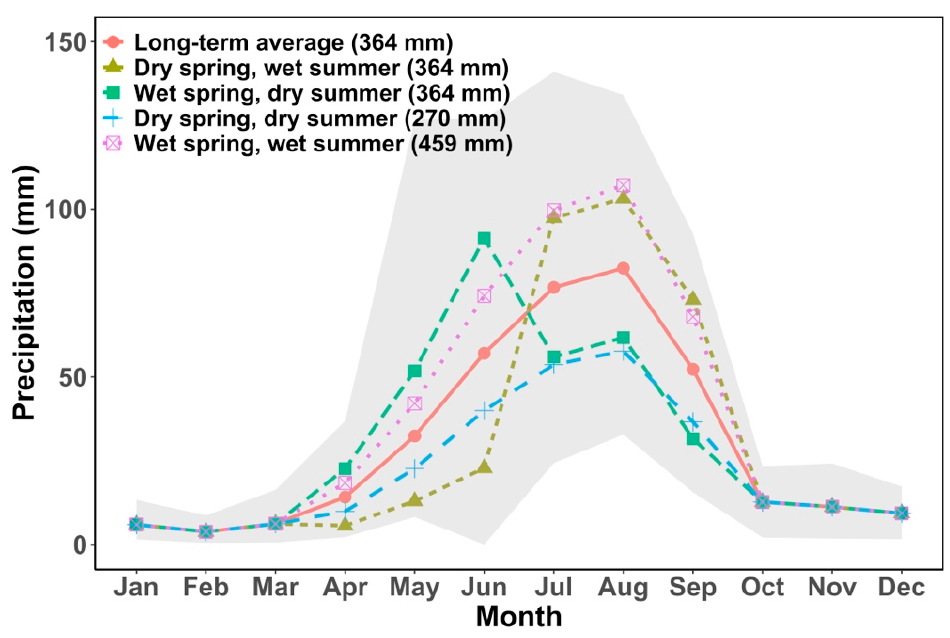
Figure 2. Long-term (1999–2017) monthly average total precipitation (mm) at a meteorological station central to the chosen study sites in SE Siberia, Russia (station ID: GHCND:RSM00030844, GPS location: 51.35° N, 110.47° E, accessed from https://www.noaa.gov/; circle (accessed on: 1 December 2019)) and proposed climatic scenarios which included shifts in precipitation distribution (triangle and square) and changes in total precipitation input (spring and summer seasons spanning from April to September; plus sign and square with cross). Shaded area in grey shows the maximum and minimum of monthly total precipitation (all forms, including snow) over the observational period. Figure 3 outlines the integrated processes followed within this study, details of each of which can be found in the following sections.